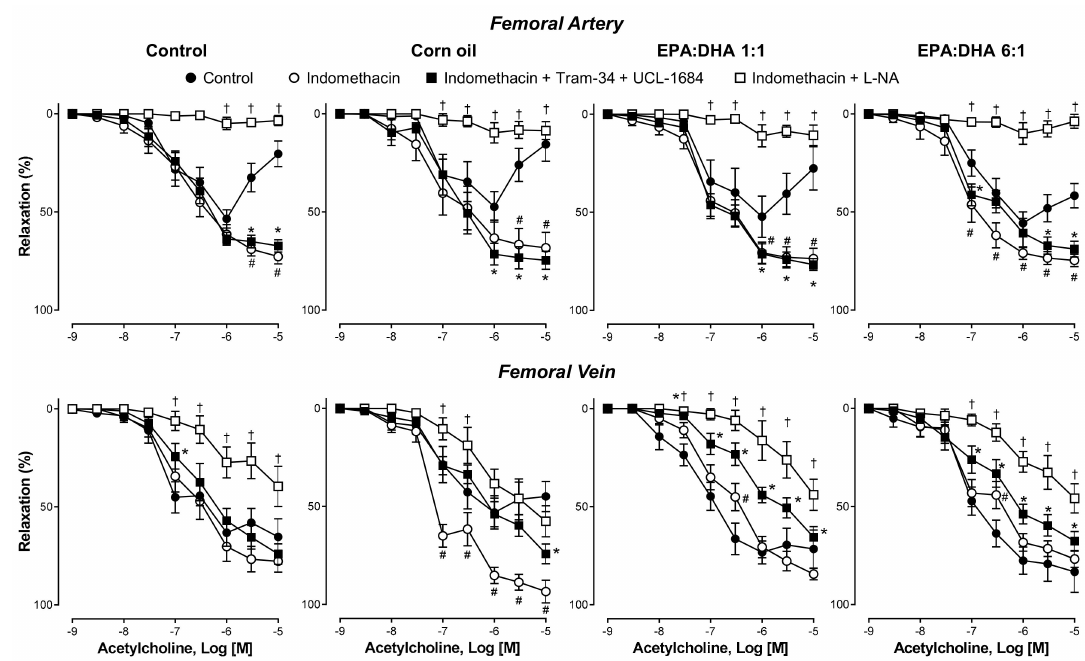
Figure 2. Characterization of the acetylcholine (ACh)-induced endothelium-dependent relaxation of the femoral artery and vein of the control, corn oil, and EPA:DHA 1:1 and EPA:DHA 6:1 groups. Rings were precontracted with serotonin (5-HT, 1 µ M) before the construction of a concentration–relaxation curve to ACh. Some rings were incubated for 20 min with indomethacin (10 µ M, non-selective inhibitor of cyclooxygenases) in the absence or presence either of TRAM-34 plus UCL-1684 (10 µ M each, inhibitors of endothelium-derived hyperpolarization (EDH)-mediated relaxation) or L-NA (300 µ M, inhibitor of endothelial nitric oxide synthase (eNOS)). Results are expressed as percentage of relaxation and given as means ± S.E.M. of ten rats per group. # p < 0.05 for indomethacin vs. control, * p < 0.05 for indomethacin + Tram-34 + UCL-1684 vs. control, and † p < 0.05 for indomethacin + L-NA vs. control. 2.3. ACh-Induced Relaxation was Improved by COX-1 Inhibition in the Femoral Artery and by